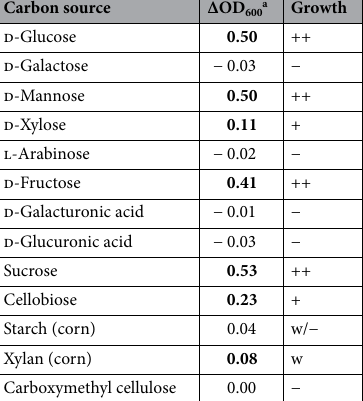
Table 4. Growth of Wickerhamomyces anomalus associated with Doubledaya bucculenta on different carbon sources. Data in bold indicate that pellets of yeasts could be observed. − no growth, w weak growth, + moderate growth, ++ strong growth. a Difference of the turbidity increase between culture media containing no and a given carbon